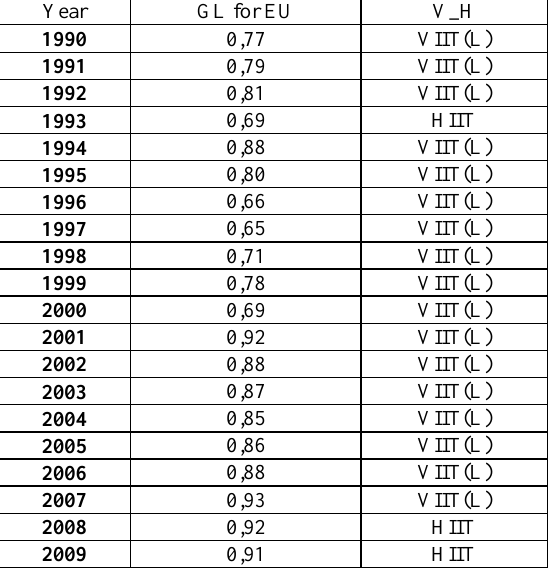
Table 5: Type of IIT (Full period)